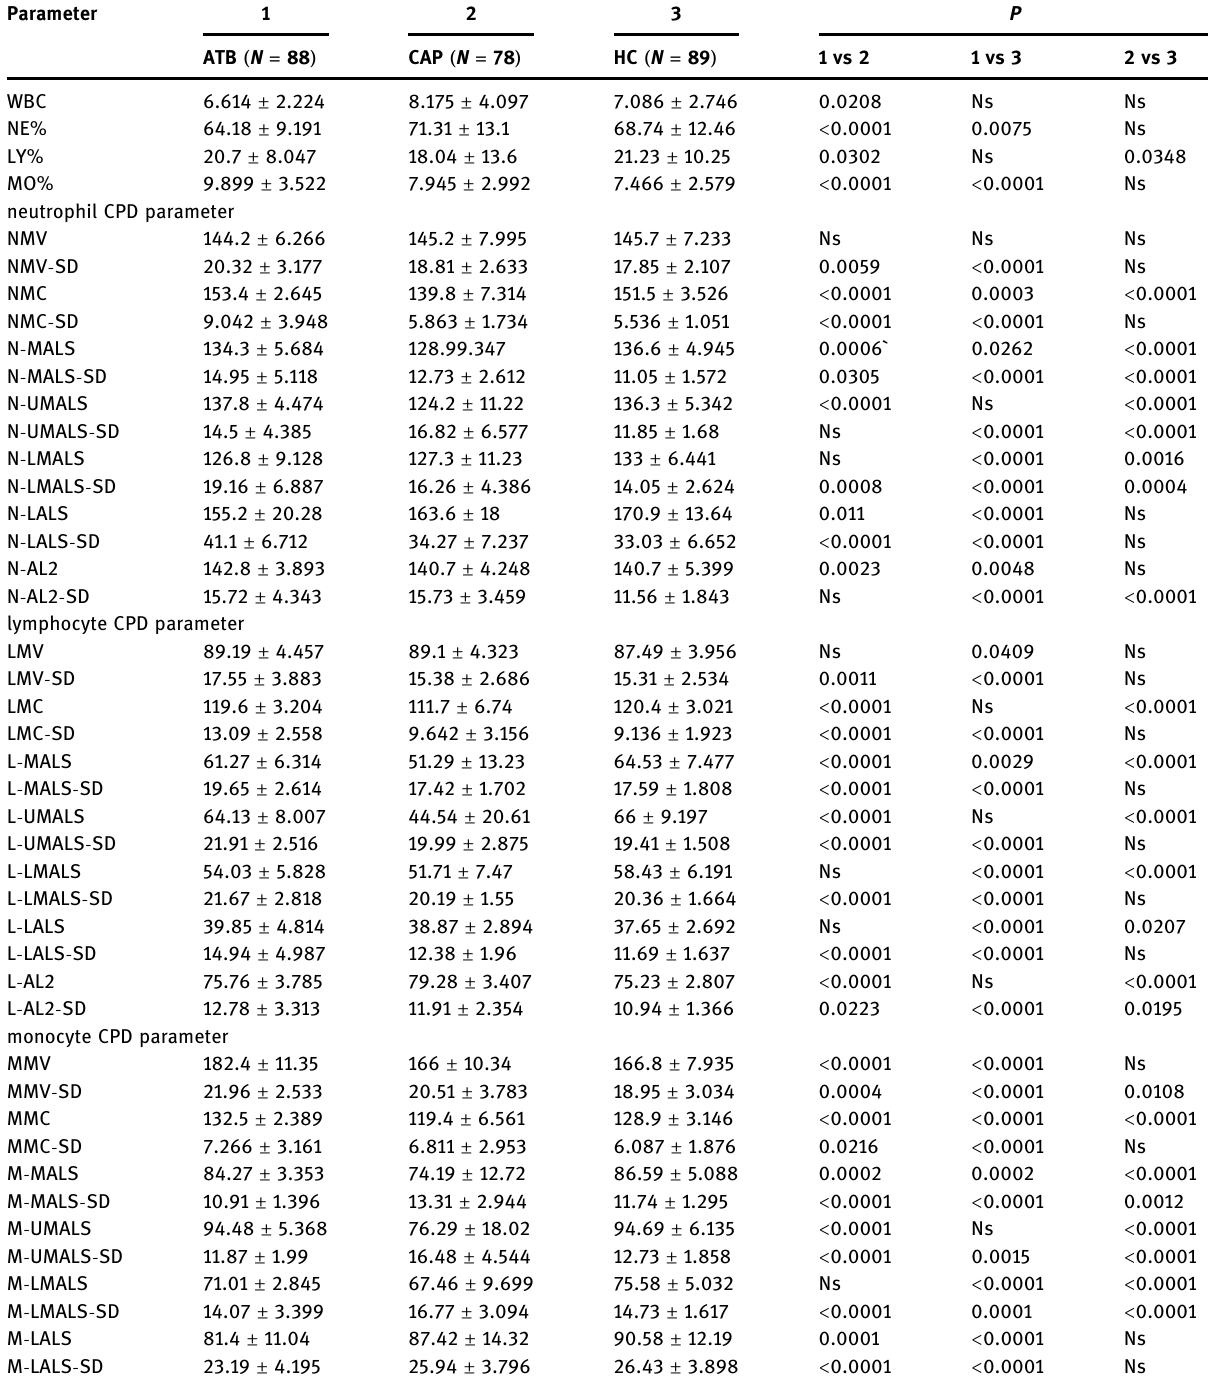
Table A1: parameters in active tuberculosis and community - acquired pneumonia and healthy control ( Mean ± SD )